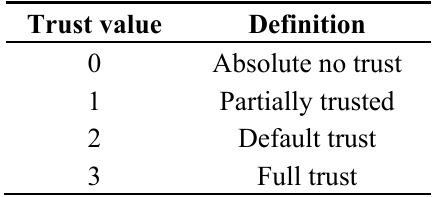
Table 3. Trust values for Gateway